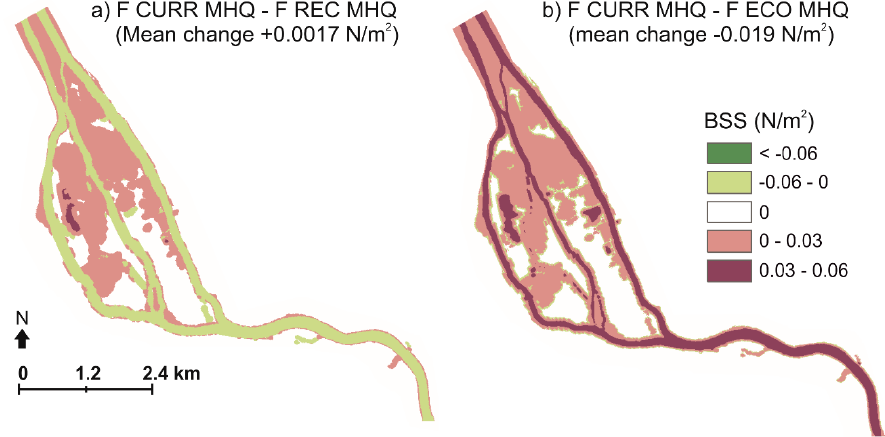
Figure 8. The e ff ect of the enhanced regulation rules to the erosional power. The di ff erence in BSS between: ( a ) the CURR and REC regulation rules (F CURR MHQ − F REC MHQ); and ( b ) the CURR and ECO regulation rules (F CURR MHQ − F ECO MHQ) during a flood in the